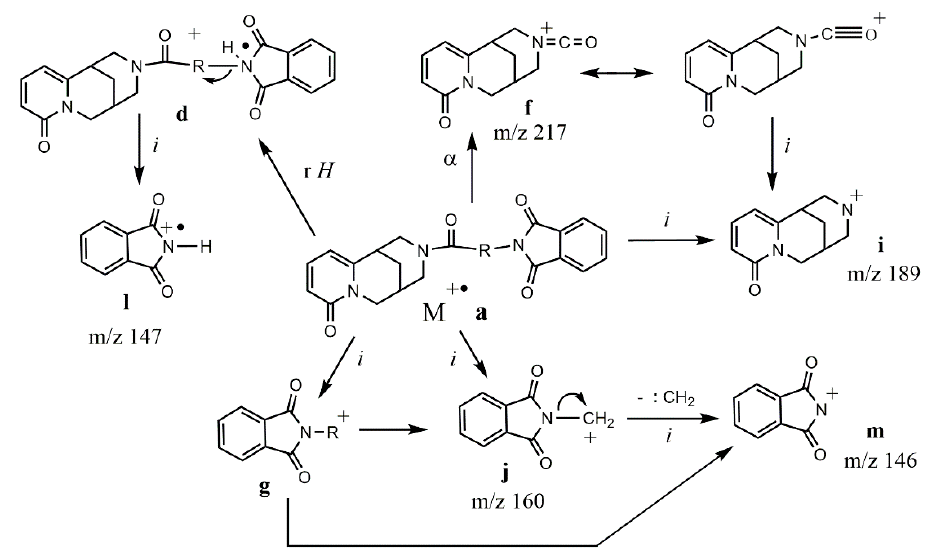
Table 2. Chemical shifts δ (ppm) of carbon atoms of cytisine ( 13 C NMR in CDCl 3